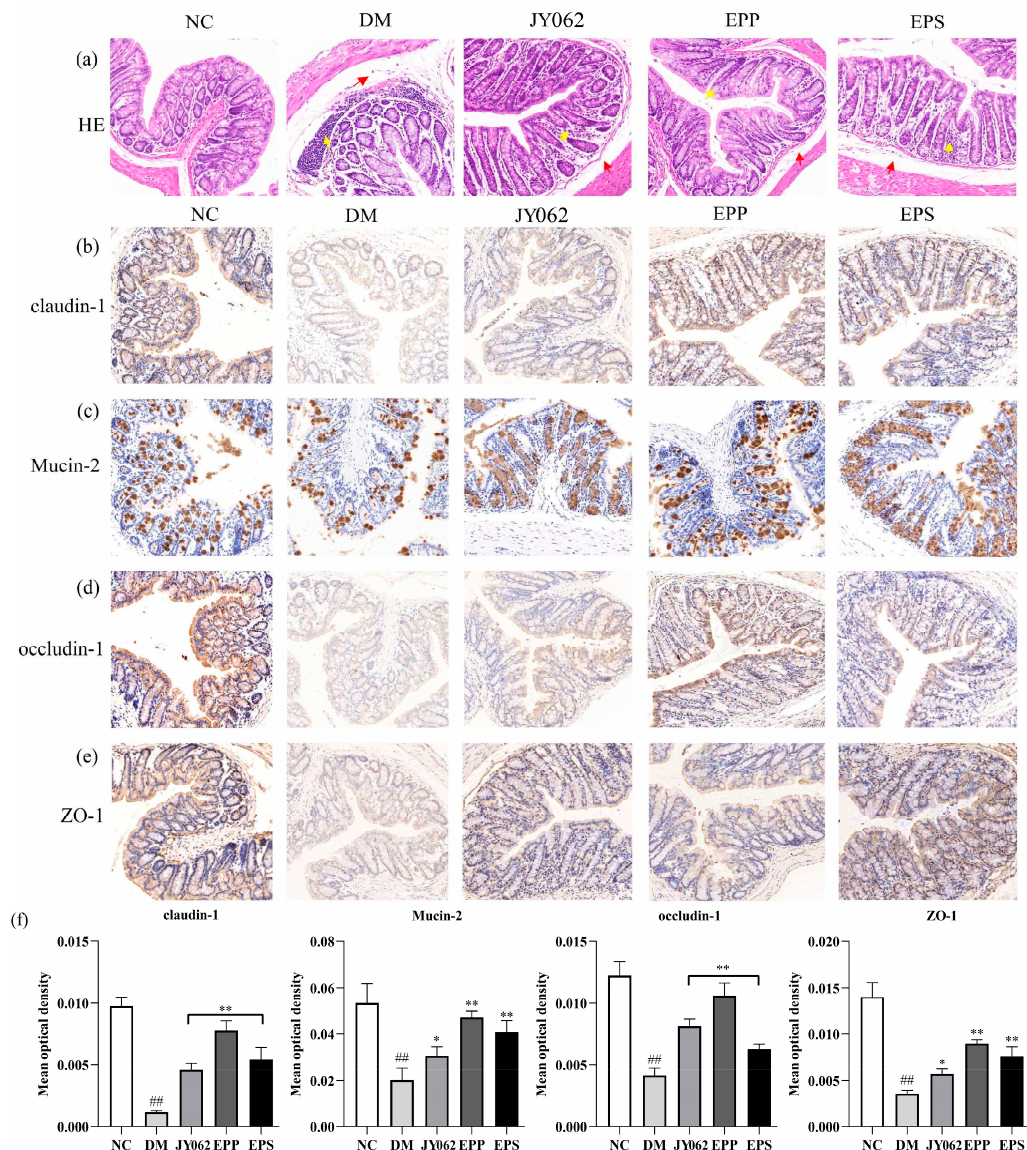
Figure 6. Effects of dietary intervention on intestinal barrier function. ( a ) The colonic microsections stained with hematoxylin-eosin (HE) (200× magnification); the protein expression of claudin-1 ( b ), Mucin-2 ( c ), occludin-1 ( d ) and ZO-1 ( e ) determined by immunohistochemistry (original magnification 200×); ( f ) the mean optical density of claudin-1, Mucin-2, occludin-1 and ZO-1. Data are presented as mean ± SD values. ## p < 0.01 vs. NC group; * p < 0.05, ** p < 0.01 vs. DM group.